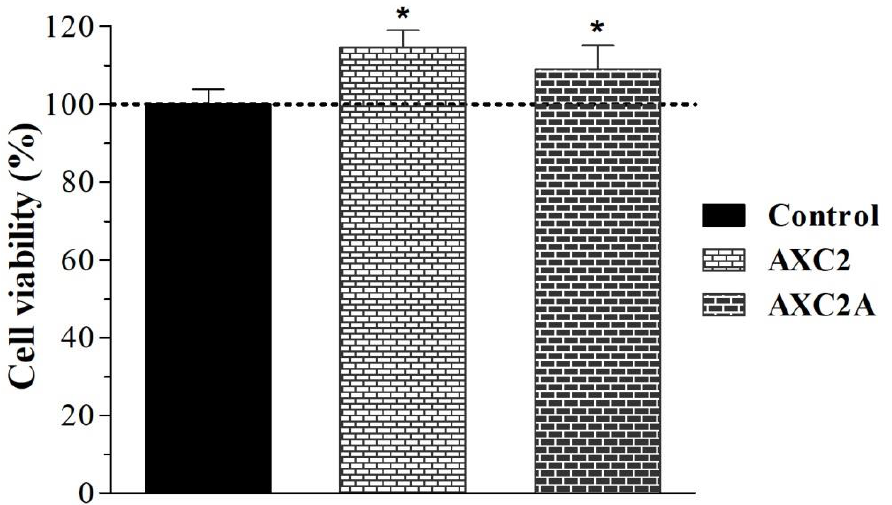
Figure 6. Cell viability (%) after treatment with AX-CMC films (mean ± SD, n = 3, * p < 0.05).